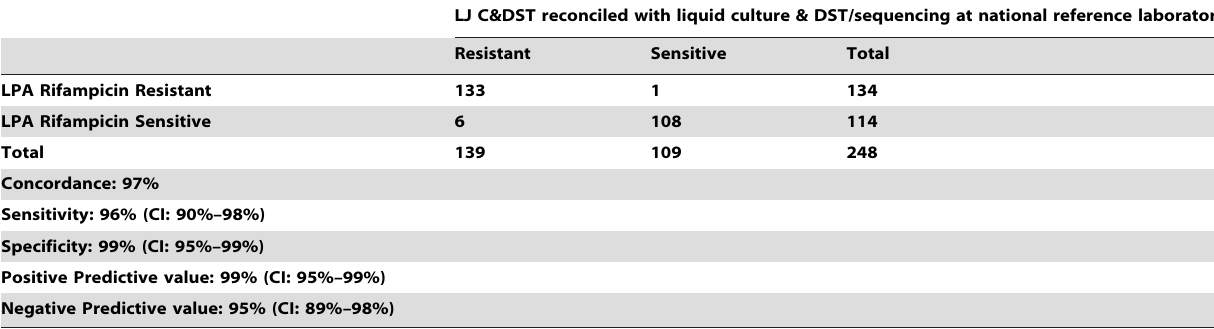
Table 6. Final reconciled results of LPA-LJ Rifampicin resistance correlation in view of sequencing and Liquid Culture and DST at National reference